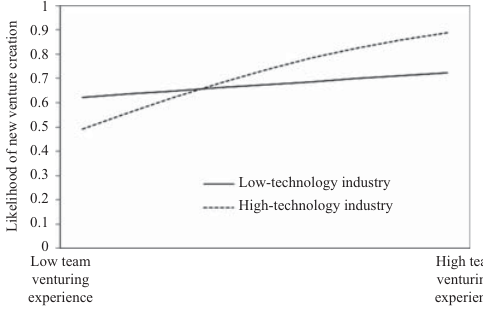
Figure 1. The moderating